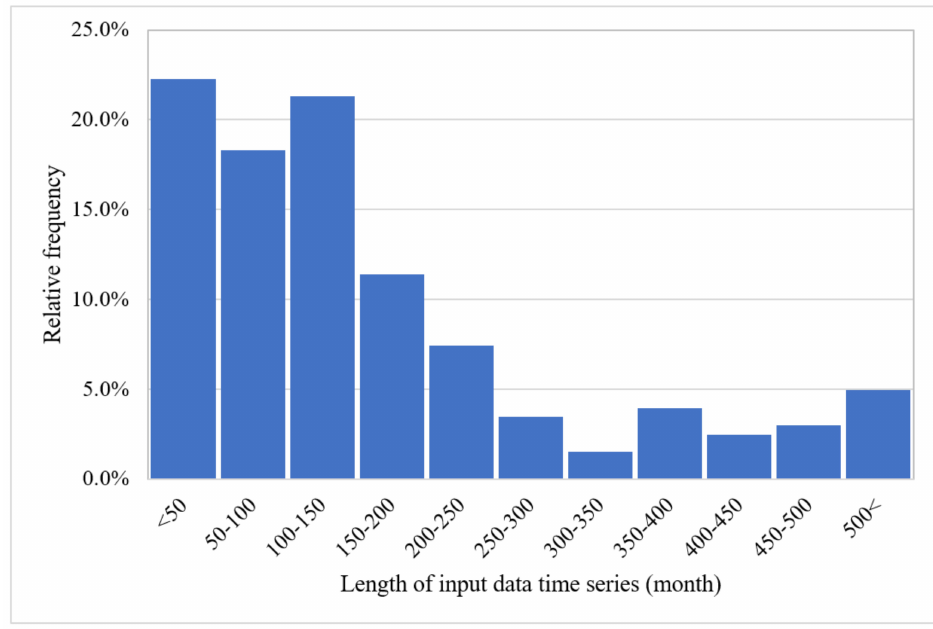
Figure 8. Percentage of the reviewed articles according to the length of the input data time